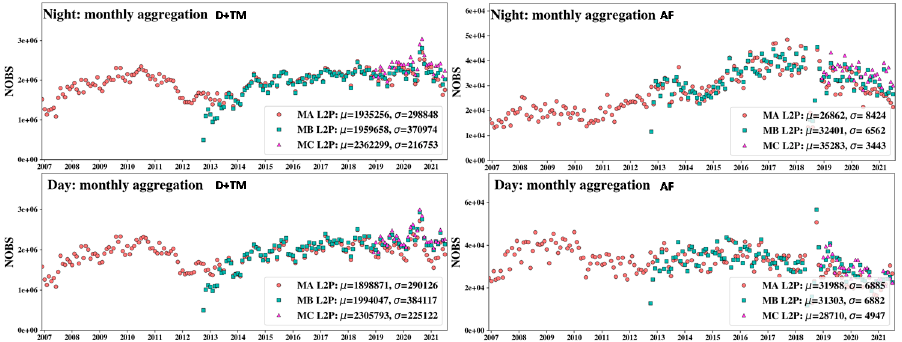
Figure 7. Time series of the monthly aggregated number of observations in the MDSs: ( top ) night; ( bottom ) day vs. ( left ) (D+TM); ( right ) AF.